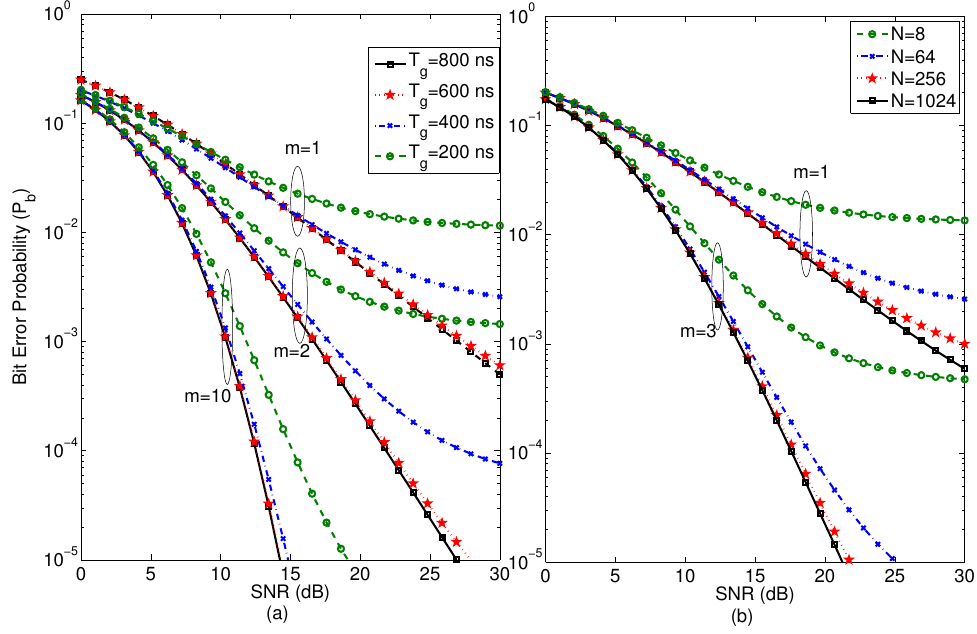
Figure 5. OFDM–QDPSK system with ( a ) N = 64 and different guard period durations and severity parameter ( m ) values ( b ) T g = 400 ns and BW = 20 MHz with different numbers of subcarriers and severity parameter ( m ) values.